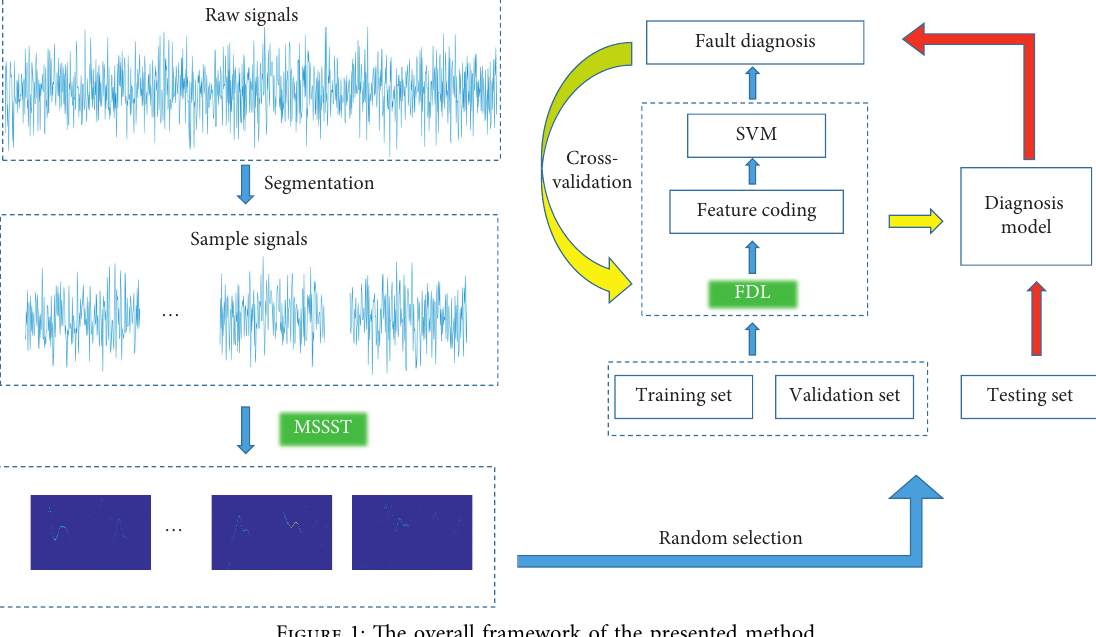
Figure 1: The overall framework of the presented method.